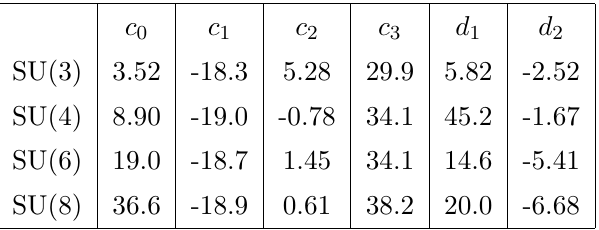
Table 2. Coefficients in eq. (3.7) for SU( N ) best-fit curves.